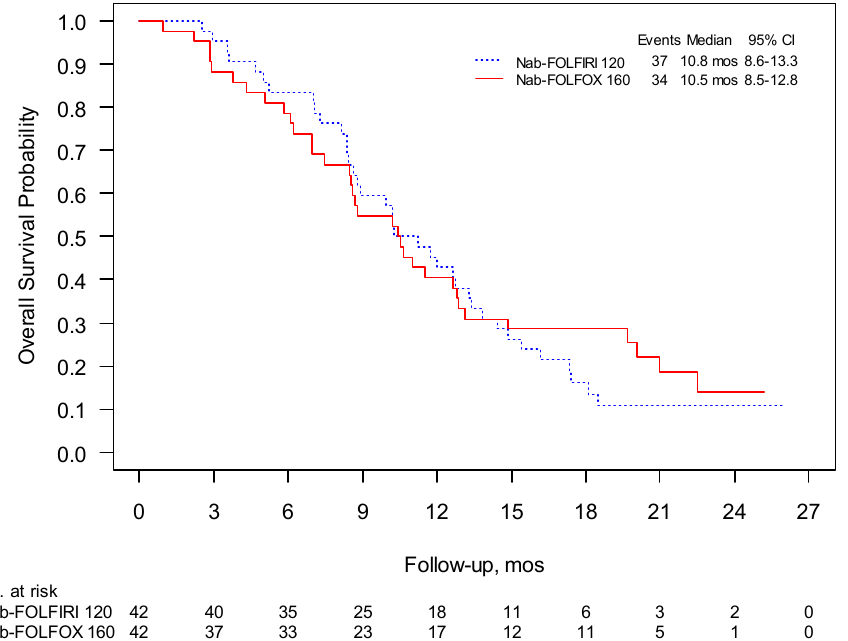
Figure 3. Phase II: overall survival (OS) was evaluated using Kaplan–Meier estimates of the median survival times (including 95% confidence intervals (CI)). Table 4. Phase II: best overall response and clinical benefit rate.